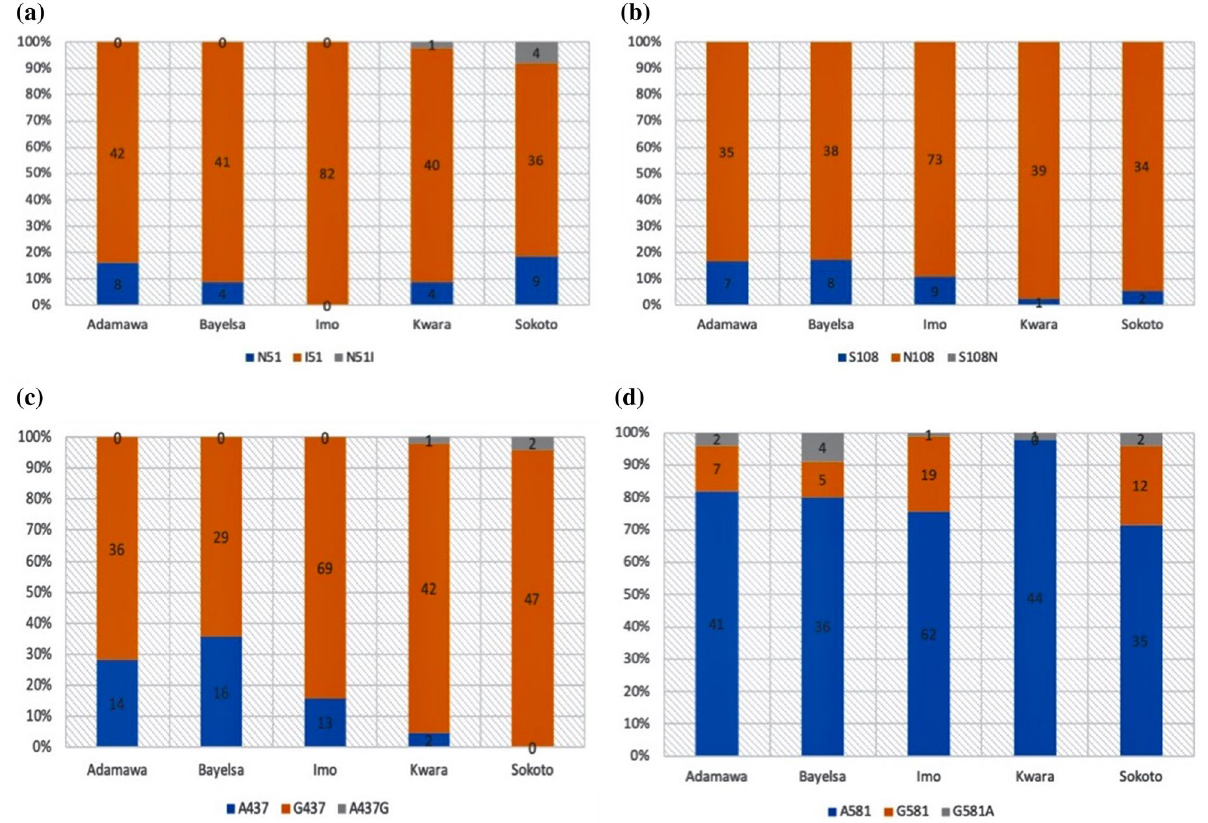
Figure 1. Bar charts showing frequencies of wild, mutant and mixed allelic infections in dhfr ( a ) Codon 51 ( b ) Codon 108 and dhps ( c ) Codon 437 and ( d ) Codon